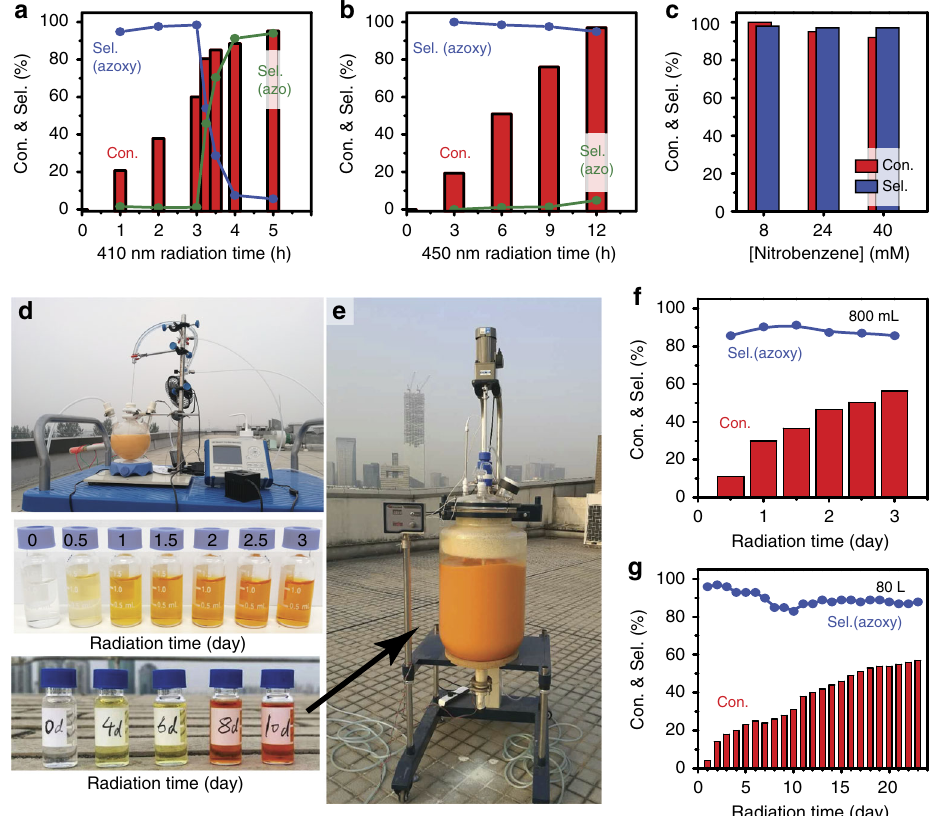
Fig. 1 Photocatalytic performance. a , b Photoconversion (Con.) and selectivity (Sel.) of nitrobenzene to azobenzene and azoxybenzene using g-C 3 N 4 under 410 and 450 nm irradiation (lab-scale). c Photoconversion of nitrobenzene to azoxybenzene using g-C 3 N 4 at different starting concentrations under 450 nm irradiation. Reaction conditions: 8 mM nitrobenzene, 10 mM KOH, and 50 mg catalyst in 10 mL isopropanol under N 2 atmosphere. d , e Up-scaled reactions with volumes of 800 mL and 80 L, respectively. The nitrobenzene photoconversion tests were performed under solar radiation in Beijing (30/9/ 2016-2/10/2016, 25-30 °C, 800 mL) and Shenzhen (18/12/2016-5/1/2017, 25 – 30 °C, 80 L). The starting concentration of nitrobenzene was 8 mM. f , g Conversion and selectivity for the scaled-up